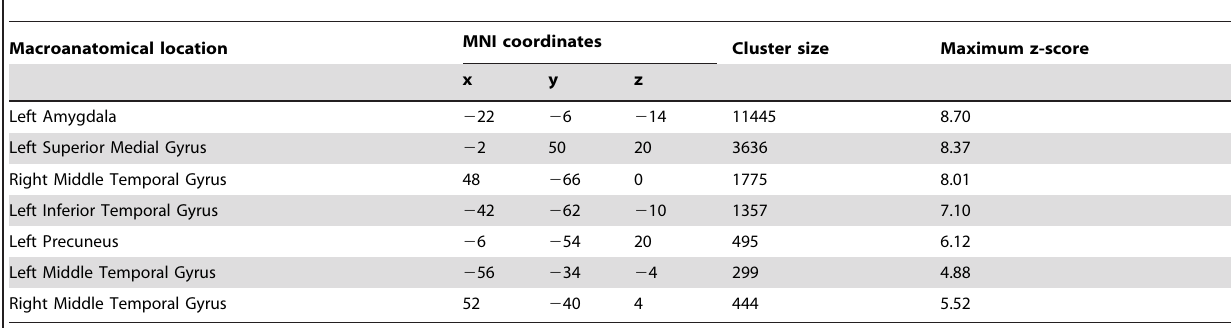
Table 2. Activation peaks of ALE meta-analysis of the neural correlates of emotional processing tasks (EMO).